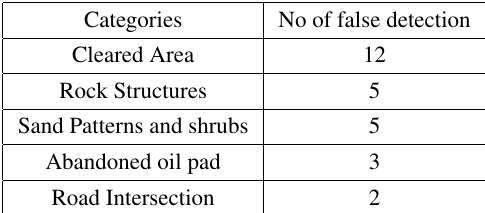
Table 5. Precision, recall, F1 score and average IoU for single and multiple oil pad